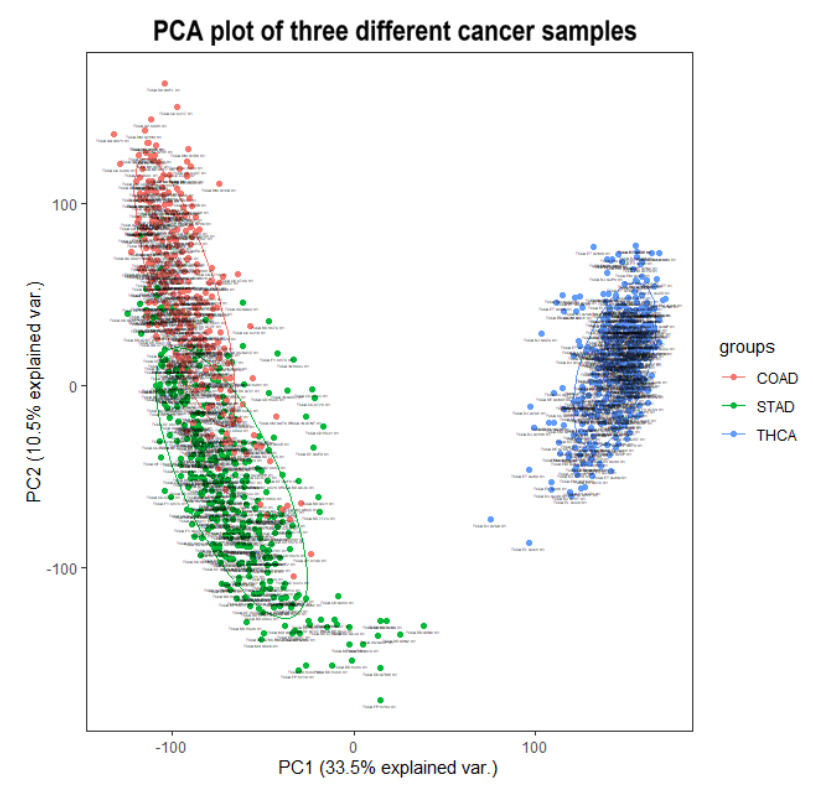
Figure 12. The PCA plot of three different cancer